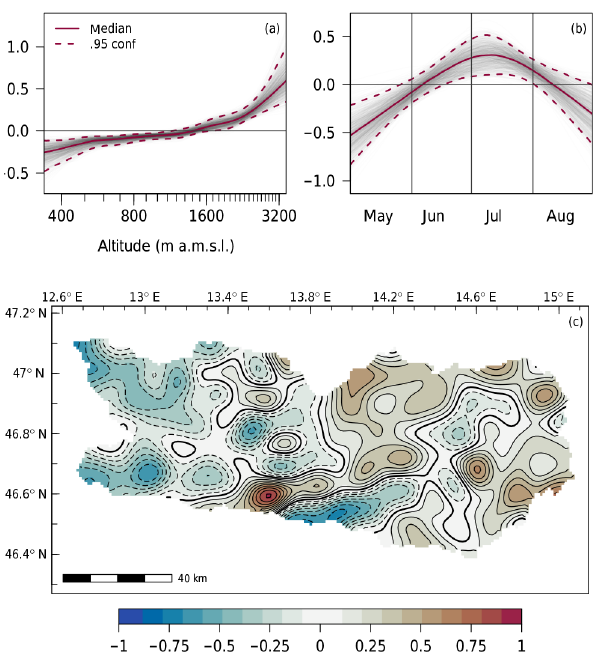
Figure 5. The effects of the intensity model on the scale of the ad- ditive predictor. Labelling is analogue to Fig. 4. (a) The altitude (lo- galt) effect. (b) The seasonal (doy) effect. (c) The spatial (lon,lat) effect.